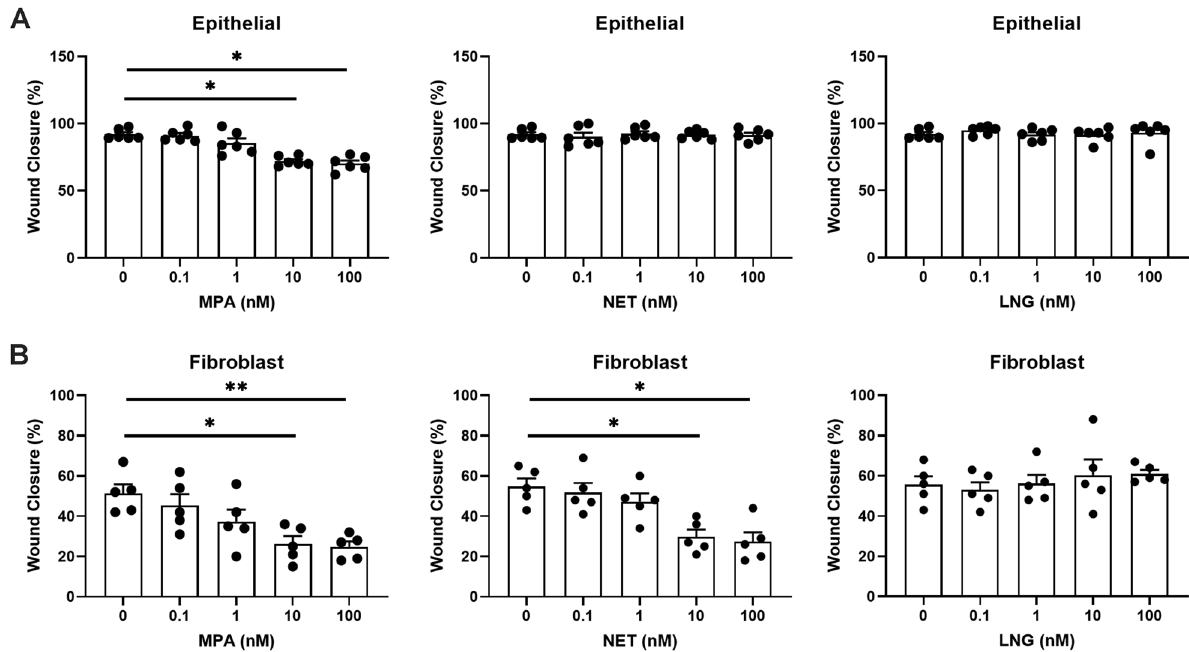
Figure 4. MPA and NET exhibit a dose-dependent suppression of wound closure in endometrial epithelial cells and stromal fibroblasts. (A) Wound closure by endometrial epithelial cells grown in transwell inserts and (B) wound closure by endometrial stromal fibroblasts grown in 24-well plates 24 h post-scratch following treatment with 0.1, 1, 10, and 100 nM MPA, NET, and LNG for 48 h prior to scratch. MPA, NET, and LNG were maintained in the cell culture media following scratch. Bars represent mean + /− SEM. Each symbol represents a single individual (epithelial cell n = 6 ; stromal fibroblast n = 5 ). *p < 0.05; **p < 0.01.